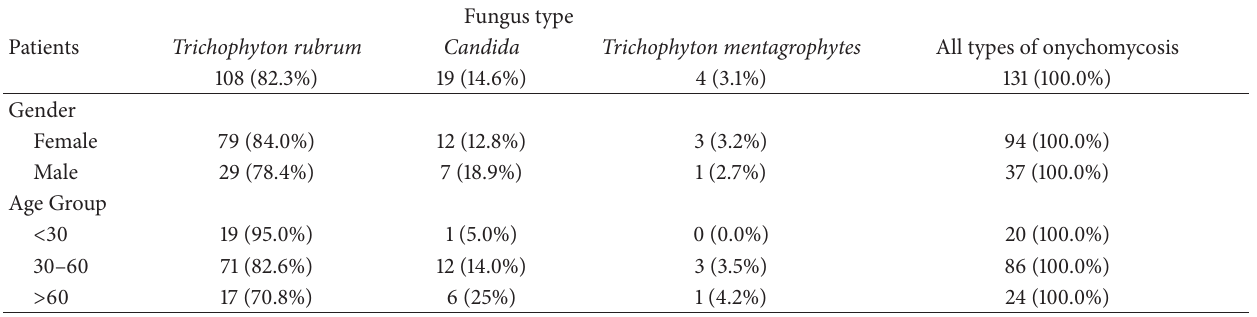
Table 2: Fungal culture results and distribution according to age and gender.